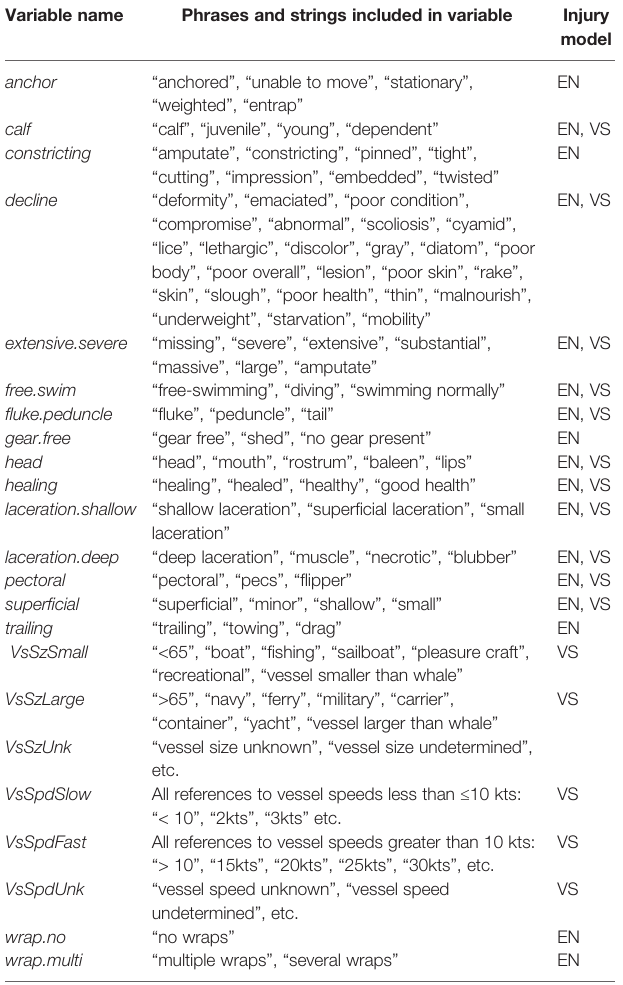
TABLE 2 | List of narrative words, phrases or characters used as variables in Random Forest entanglement (EN) and vessel strike (VS) models. Variable name Phrases and strings included in variable